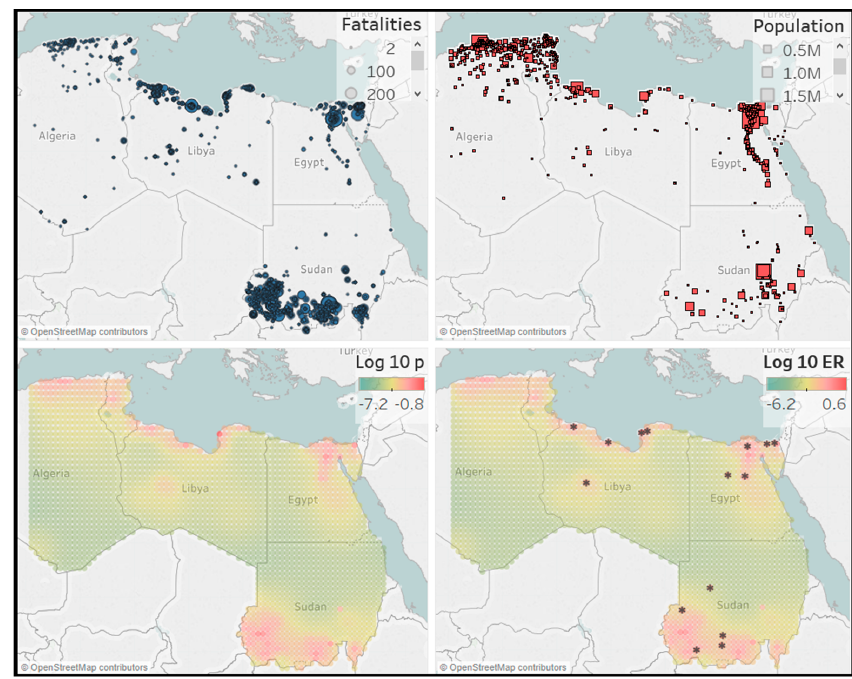
Figure 11. Forecasts for North Africa. Top left: event catalog 2012–2016. Top right: City map with cities with 1000+ population. Bottom left: spatial background distribution estimated from the data from 2012–2016. Bottom right: forecast for the expected number of events with 𝑀 ≥ 4 in each cell in the year 2017, together with the locations of the actual conflicts that have taken place with 𝑀 ≥ 4 .